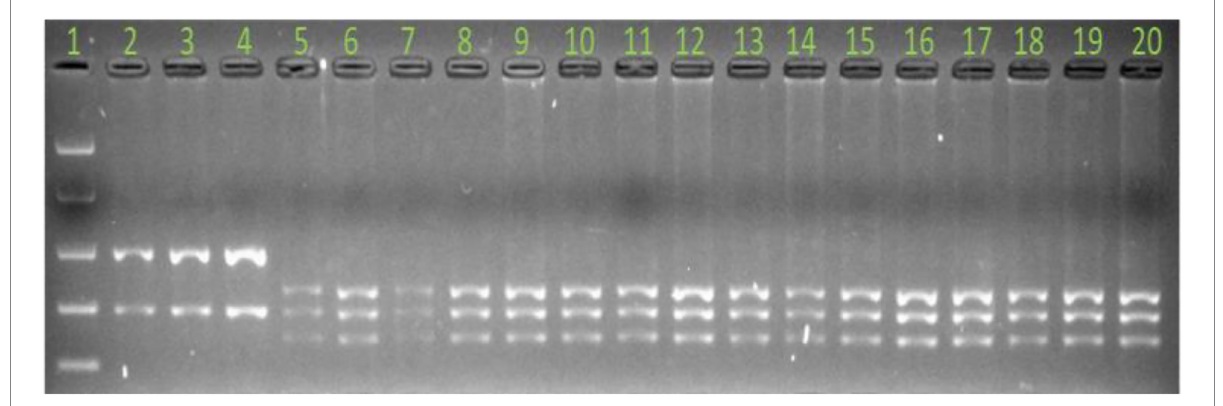
FIGURE 1 Marker validation on Australian barley cultivars with marker MLoc-70. Products were digested with restriction enzyme BSrI. Lane number 1 = easy ladder (Bioline). Lane numbers 2, 3, and 4 = PI 584760, Bowman + Rph14 and resistant parent AGG-396, respectively. Lane numbers 5 to 7 = Gus, Bowman and Morex, respectively, and lane numbers 8 to 20 Australian Barley cultivars. Note the presence of susceptible allele for all cultivars shown in this image relative to lanes 2, 3, and 4, which are leaf rust resistant